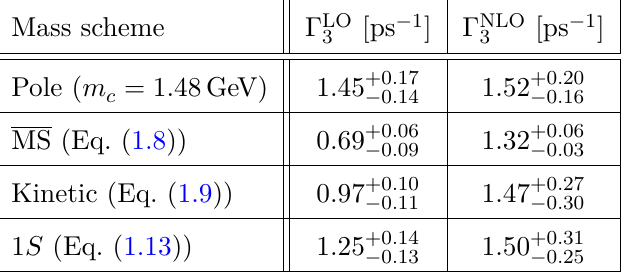
= Γ (0) and Γ NLO = Γ (0) + α ( m ) / (4 π ) Γ (1) using different s c 3 3 3 3 3